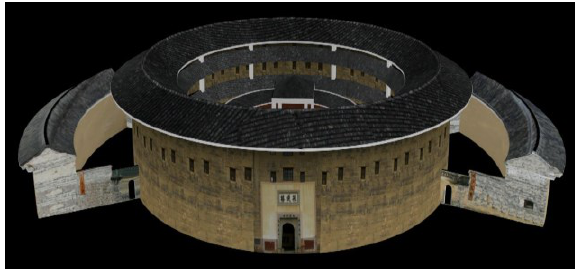
Figure 4. 3D reconstruction of Zhengyang Tulou with integrated point clouds from UAV photogrammetry and TLS